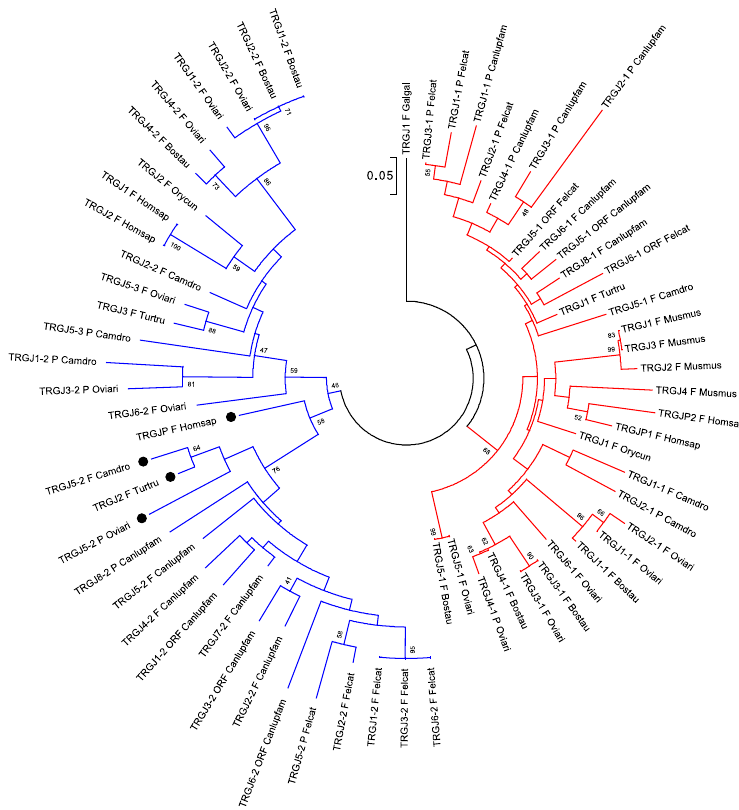
Figure 4. Evolutionary relationships of the eutherian mammalian TRGJ genes. The TRGJ coding sequences of all mammalian species were included in the tree. A chicken (Galgal) TRGJ gene was used as outgroup [66]. Multiple alignments of the gene sequences were carried out using the MUSCLE program [111]. The evolutionary analyses were conducted in MEGA7 [112]. We used the neighbor-joining (NJ) method to reconstruct the phylogenetic tree [113]. The percentage of replicate trees in which the associated taxa clustered together in the bootstrap test (100 replicates) is shown next to the branches [114]. The trees are drawn to scale, with branch lengths in the same units as those of the evolutionary distances used to infer the phylogenetic trees. The evolutionary distances were computed using the p-distance method [115] and the units are the number of base differences per site. The analysis involved 67 nucleotide sequences. All positions containing gaps and missing data were eliminated. There were a total of 39 positions in the final dataset. The C-proximal TRGJ genes are shown in red; the C-distal TRGJ genes are shown in blue. The TRGJ genes occupying the middle position of the J cluster formed by three genes within each own TRG locus are marked with a black circle. The IMGT six-letter standardized abbreviations for species (Homsap (human), Musmus (mouse), Felcat (cat), Bostau (bovine), Oviari (sheep), Camdro (dromedary), Turtru (dolphin), Orycun (rabbit)) and nine-letter standardized abbreviation for subspecies (Canlupfam, dog) taxa are used.